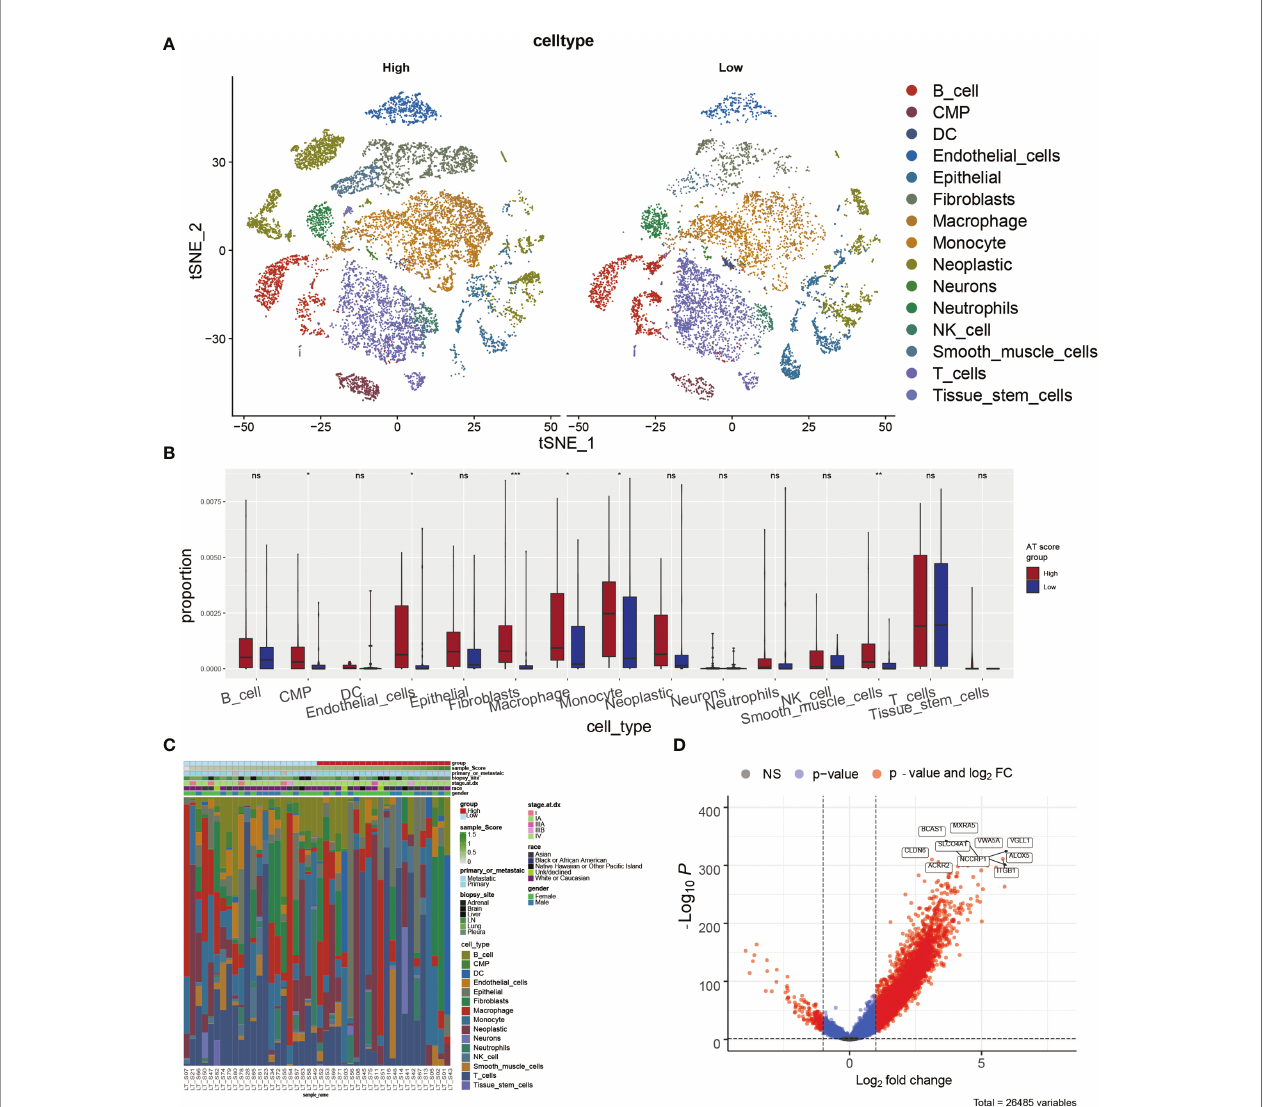
FIGURE 6 | The correlation of ATscores with the single-cell characteristics. The single-cell patterns showed that tumor samples with higher ATscore had signi fi cantly more Neoplastic cells compared with low ATscore group (A) . The statistical analysis results of immune cells diversity assay showed that the tumor samples with lower ATscores had a lower proportion of common myeloid progenitor (CMP), macrophage, and monocyte than those with higher scores (B) , and the immune cells diversity between two ATscore groups was remarkable (C) . The DEGs between the single-cell samples with different levels of ATscores were visualized, and the most remarkable genes were identi fi ed (D) . *P<0.05, **P<0.01, ***P<0.001, ****P<0.0001. “ ns ” means no signi fi